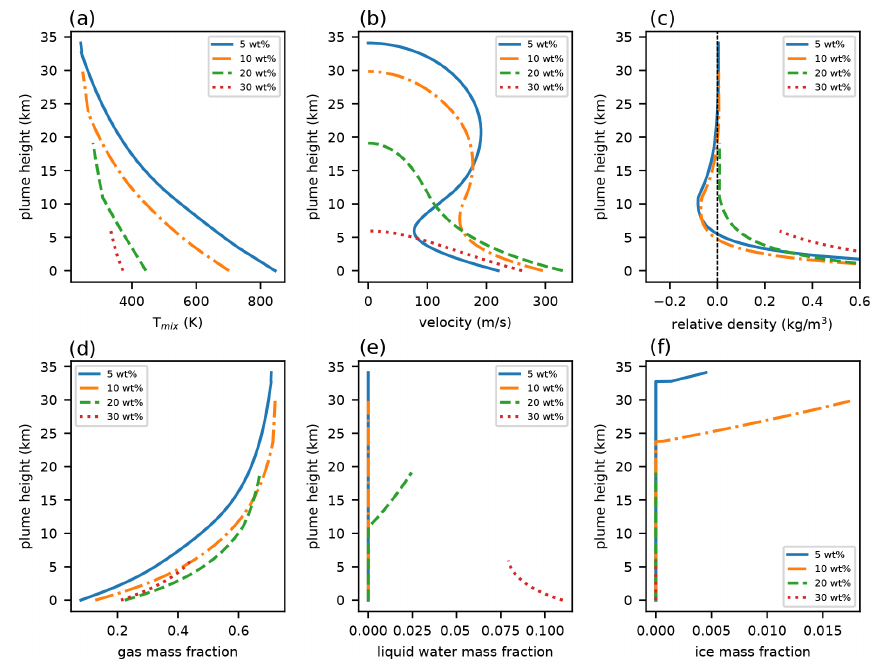
Figure C3. As in Fig. C3, but the model is initialized with a vent radius of